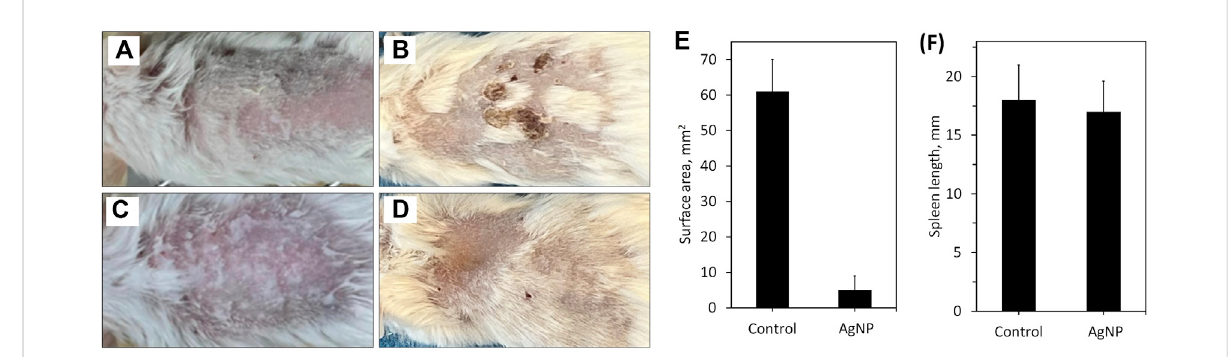
Macroscopic evaluationofburninjuryonmice: (A) 1 dayafterburninjuryincontrolgroup; (B) 4 daysafterburninjuryincontrolgroup; (C) 1 day after burninjury intreatment group; (D) 4 daysafter burninjuryinthetreatment group; (E) changesinthesurfaceareaafter experimentat4 days; (F) changes in the spleen length after experiment at 4 days.